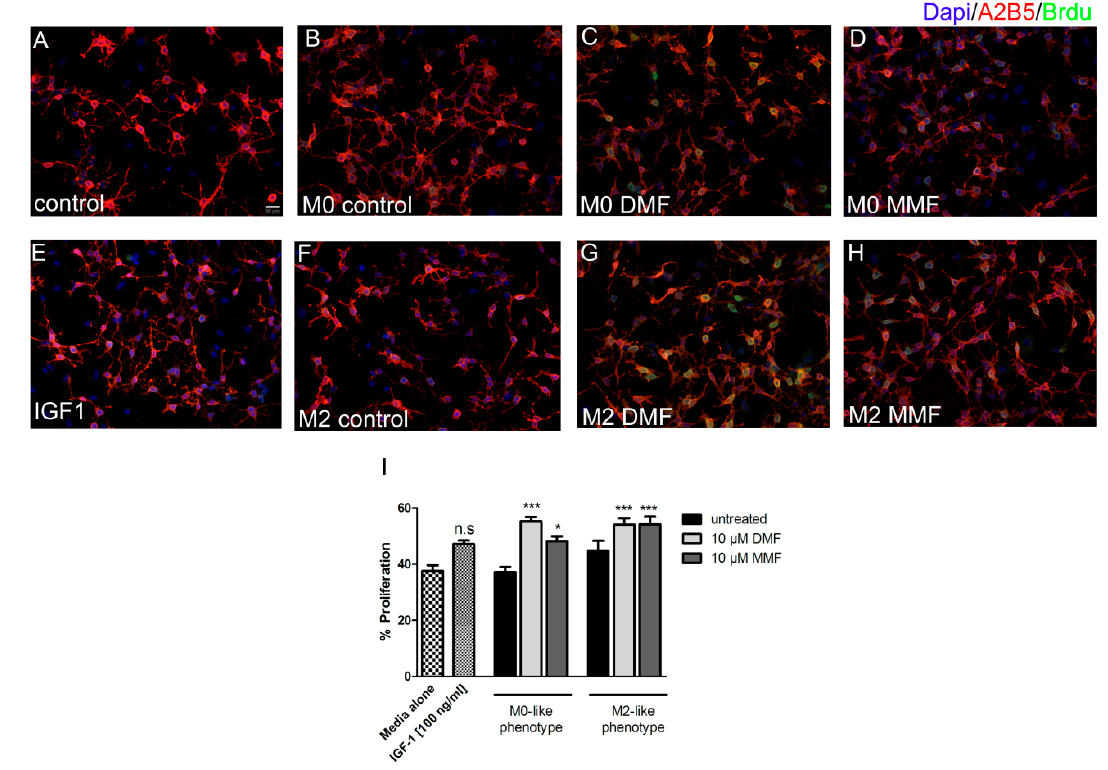
Figure 5. Effect of microglia supernatants treated with DMF or MMF on OPC proliferation. OPCs were plated in proliferation medium for 24 h and were incubated for further 48 h with supernatants from polarized microglia treated with medium, 10 µ M DMF or 10 µ M MMF. A2B5 ( red )/BrdU ( green ) double staining of cell cultures ( A – H ). Proliferation of OPC was increased after incubation with M0-like and M2-like microglia supernatants, which were treated with 10 µ M DMF or 10 µ M MMF ( I ). Data are presented as arithmetic means ± SEM of n = 4. Significant differences are marked by asterisks (* p < 0.05; ** p < 0.01; *** p < 0.001).